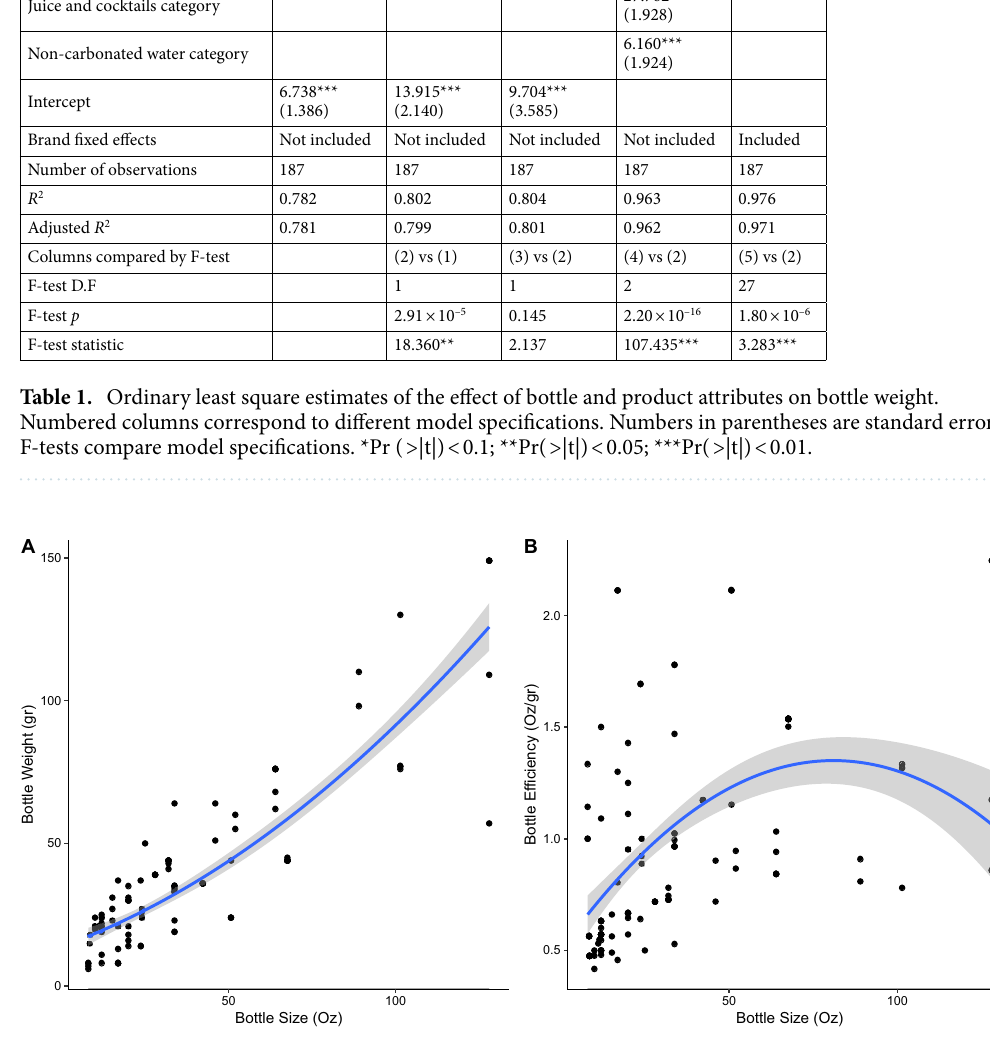
Figure 1. Relationships between bottle capacity and weight (A) , and between bottle capacity and efficiency (B) ( n = 187). The blue line represents the best quadratic approximation and the gray envelope its standard